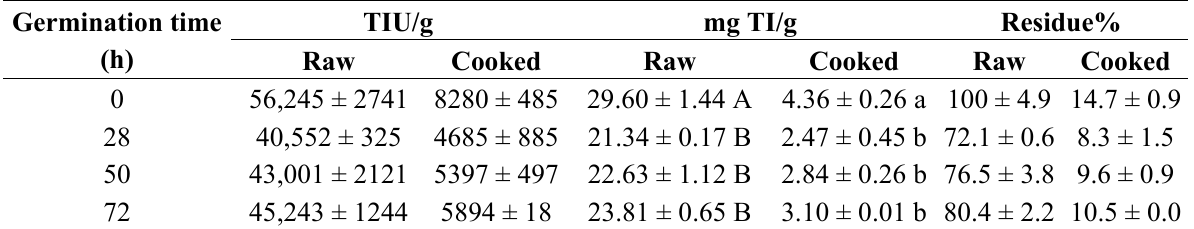
Table 1. Effect of germination time on trypsin inhibitor (TI) activity of soy milk a